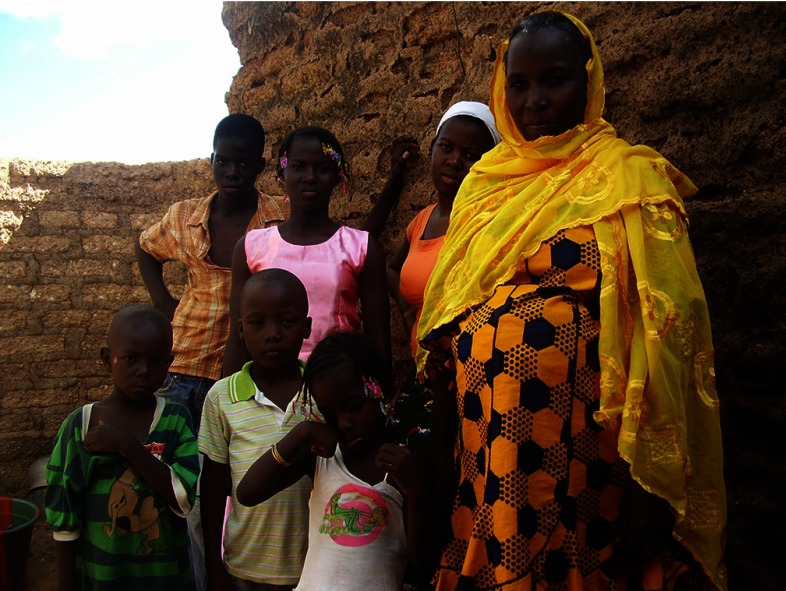
A woman in West Africa with her 6 children. High parity pregnancies can lead to complications including anemia in the mother, postpartum hemorrhage, and fetal malpresentation. © 2014 Dieneba Ouedraogo.